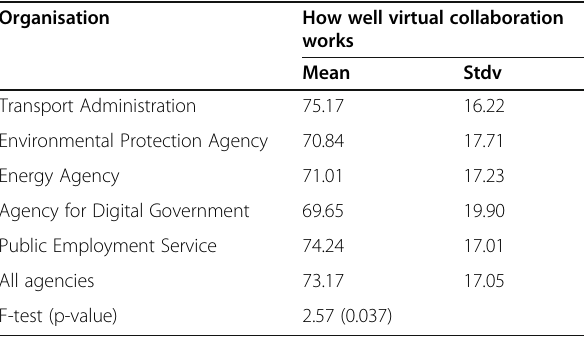
Table 9 Responses to the Question ‘ How Well Do You Think Virtual Collaboration Has Worked for You in Your Work and for the Projects in Which You Participate (Rating 1 – 100)? ’ Organisation